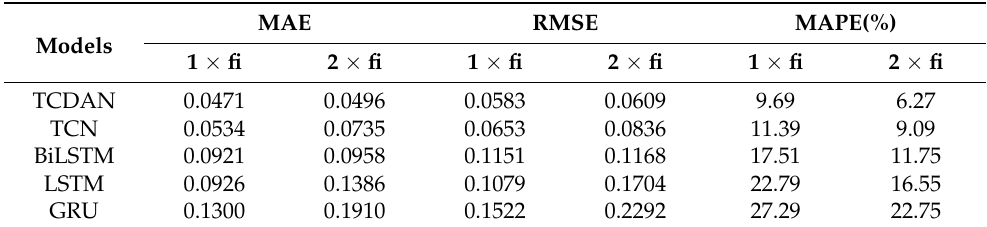
Table 3. Evaluation metrics of different prediction models for Bearing 2_1.